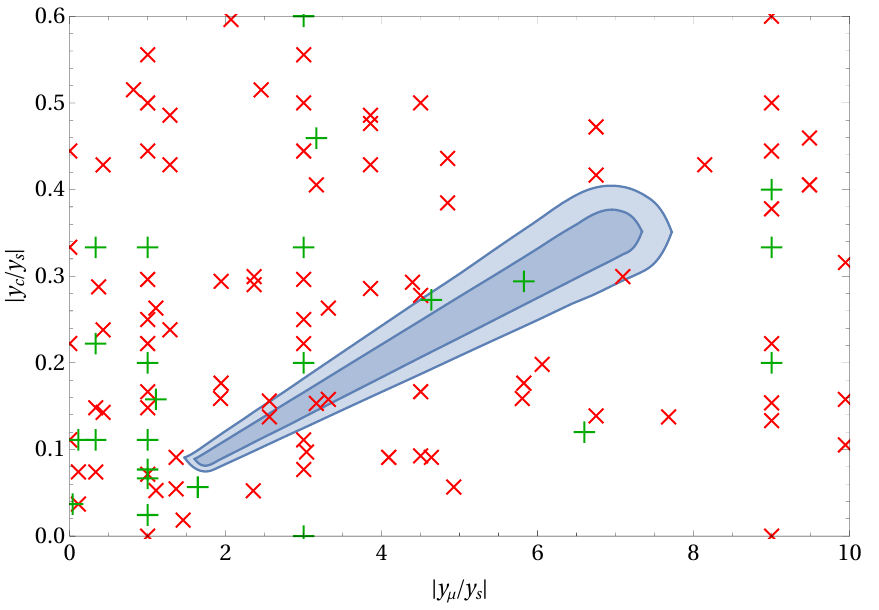
Figure 2 . The plane of Yukawa ratios j y (cid:22) =y s j and j y c =y s j at the GUT scale assuming Yukawa uni(cid:12)cation for the 3rd family. The darker blue area indicates the region where the (cid:12)t of the 4 directly observable ratios has (cid:31) 2 < 1, and the lighter blue area where (cid:31) 2 < 4. Furthermore, the crosses indicate predicted ratios by the model in Example 1 (see main body text): the green ones correspond to a O 22 operator with only the representations 45 and no 210 , while the red crosses correspond to operators with at least one 210